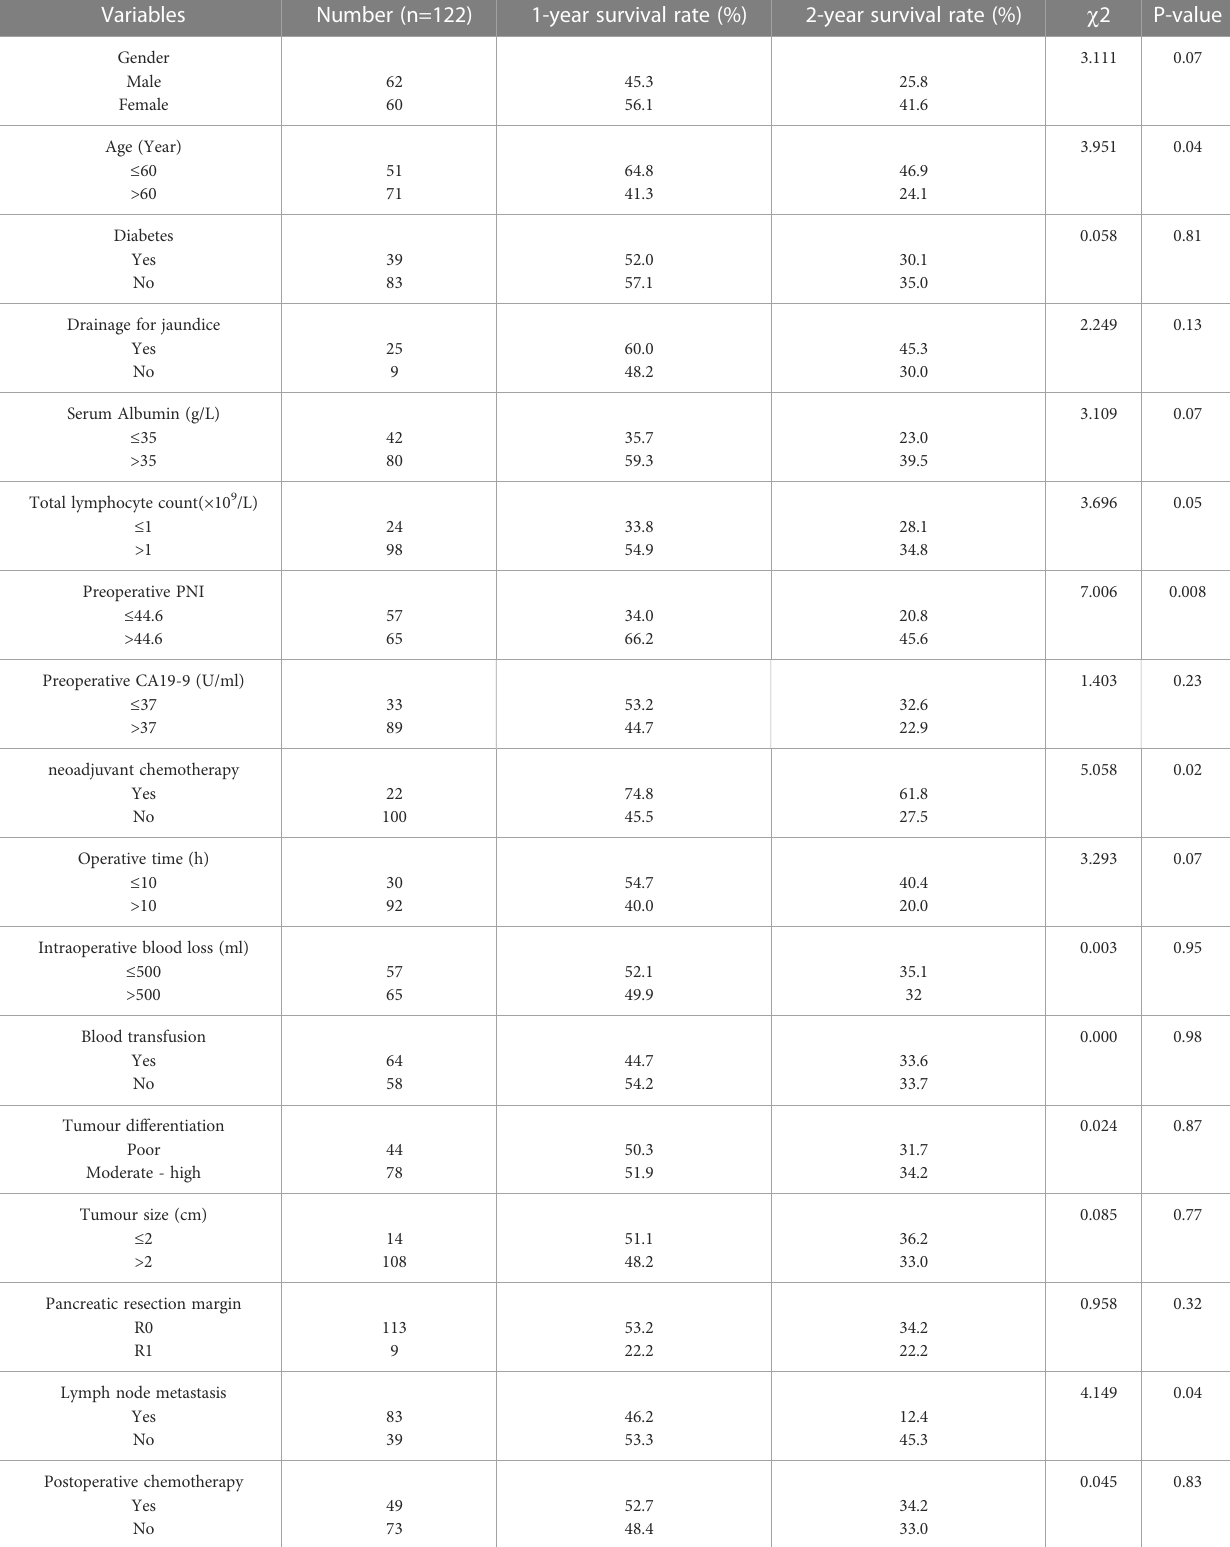
TABLE 2 Univariate analysis of risk factors for BRCP